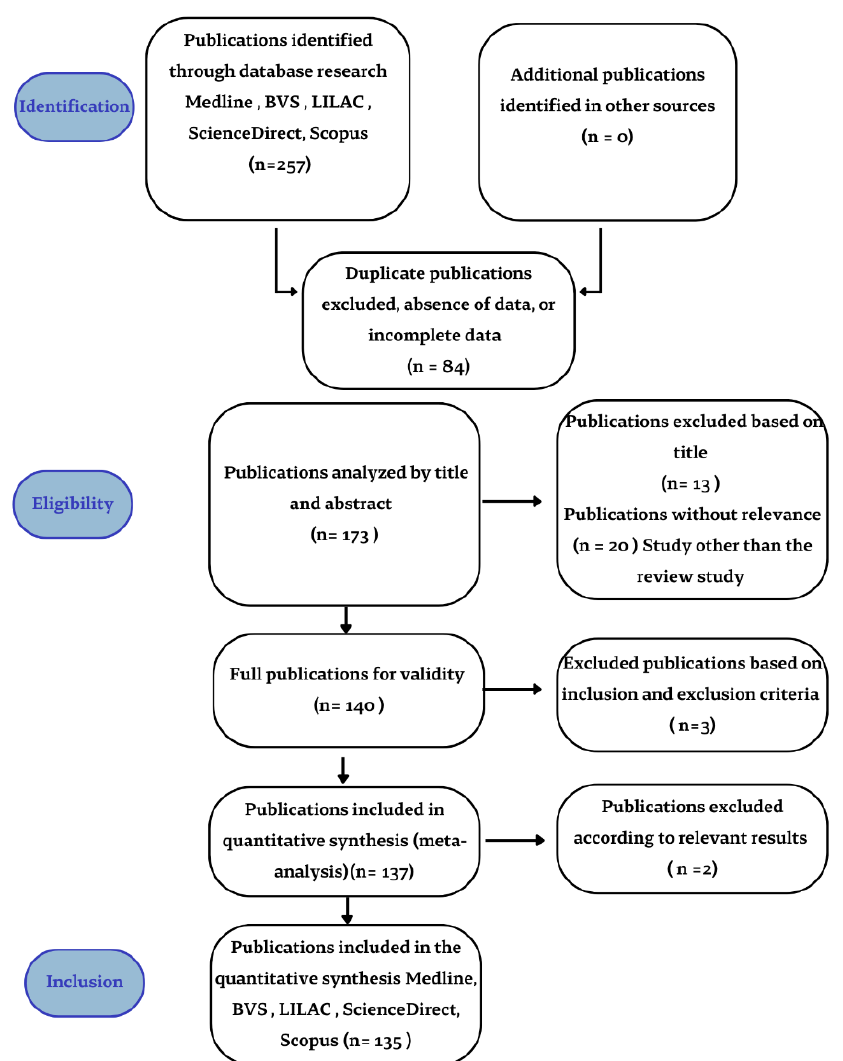
Figure 1. PRISMA flowchart of the literature systematic